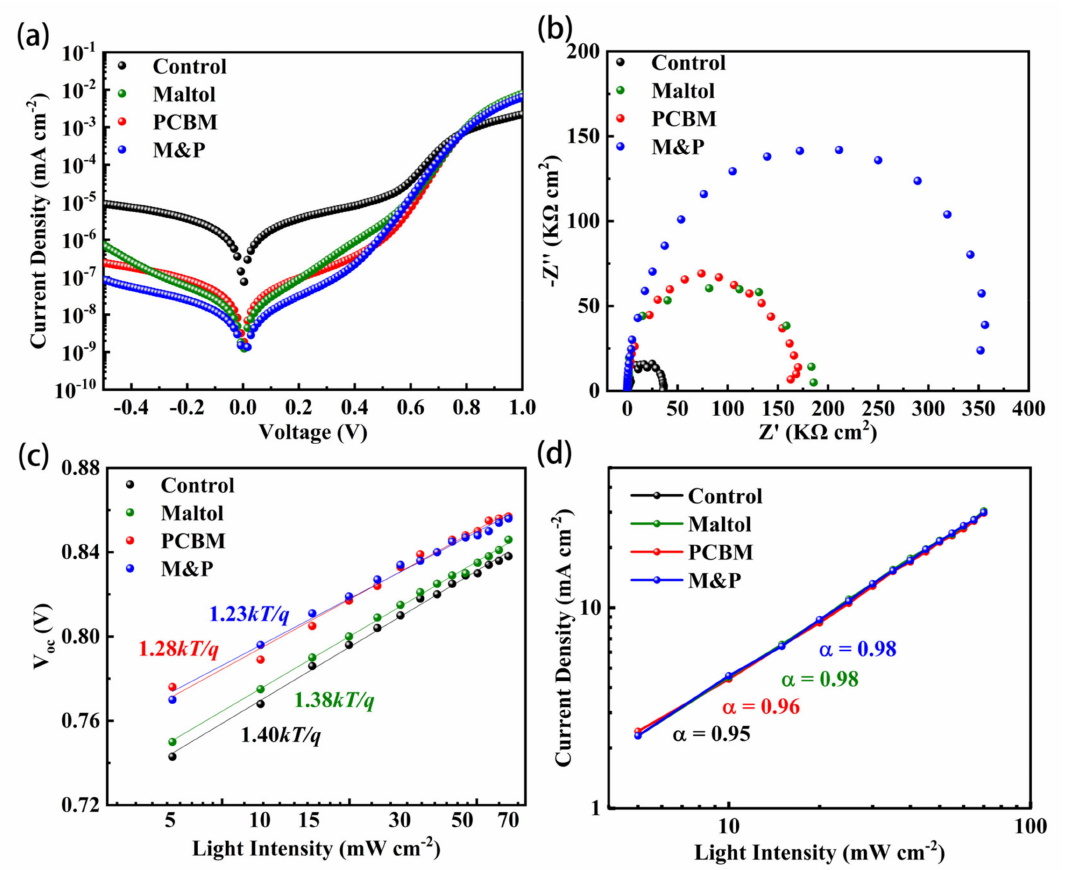
Figure 3. Characterizations of electrical properties of the four different PSCs. ( a ) Dark J-V curves, ( b ) Nyquist plots, ( c ) V oc , and ( d ) J sc as a function of light